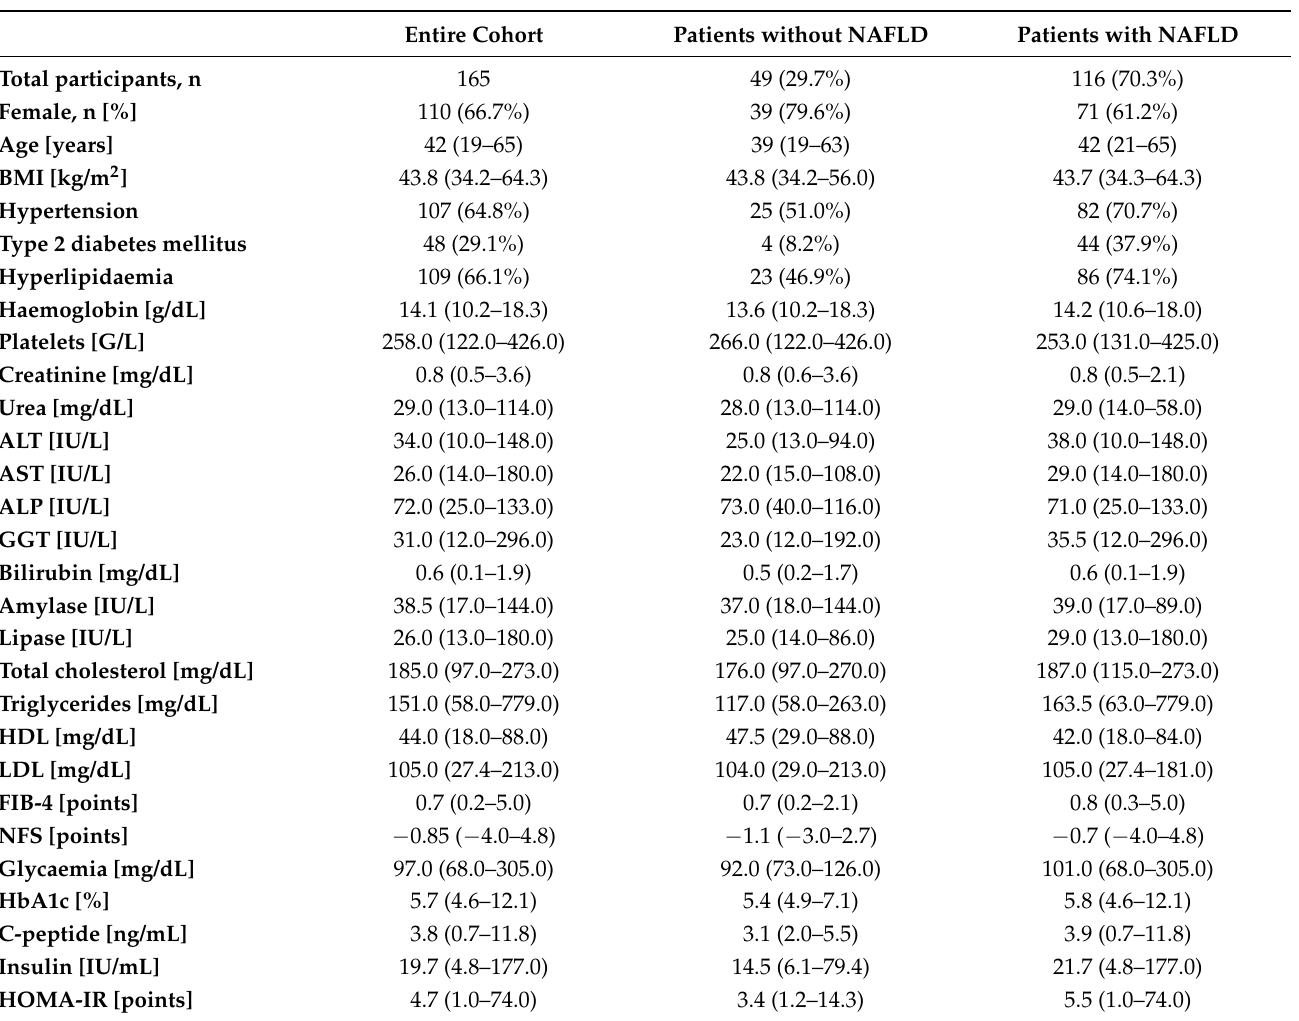
Table 1. Baseline characteristics of the study